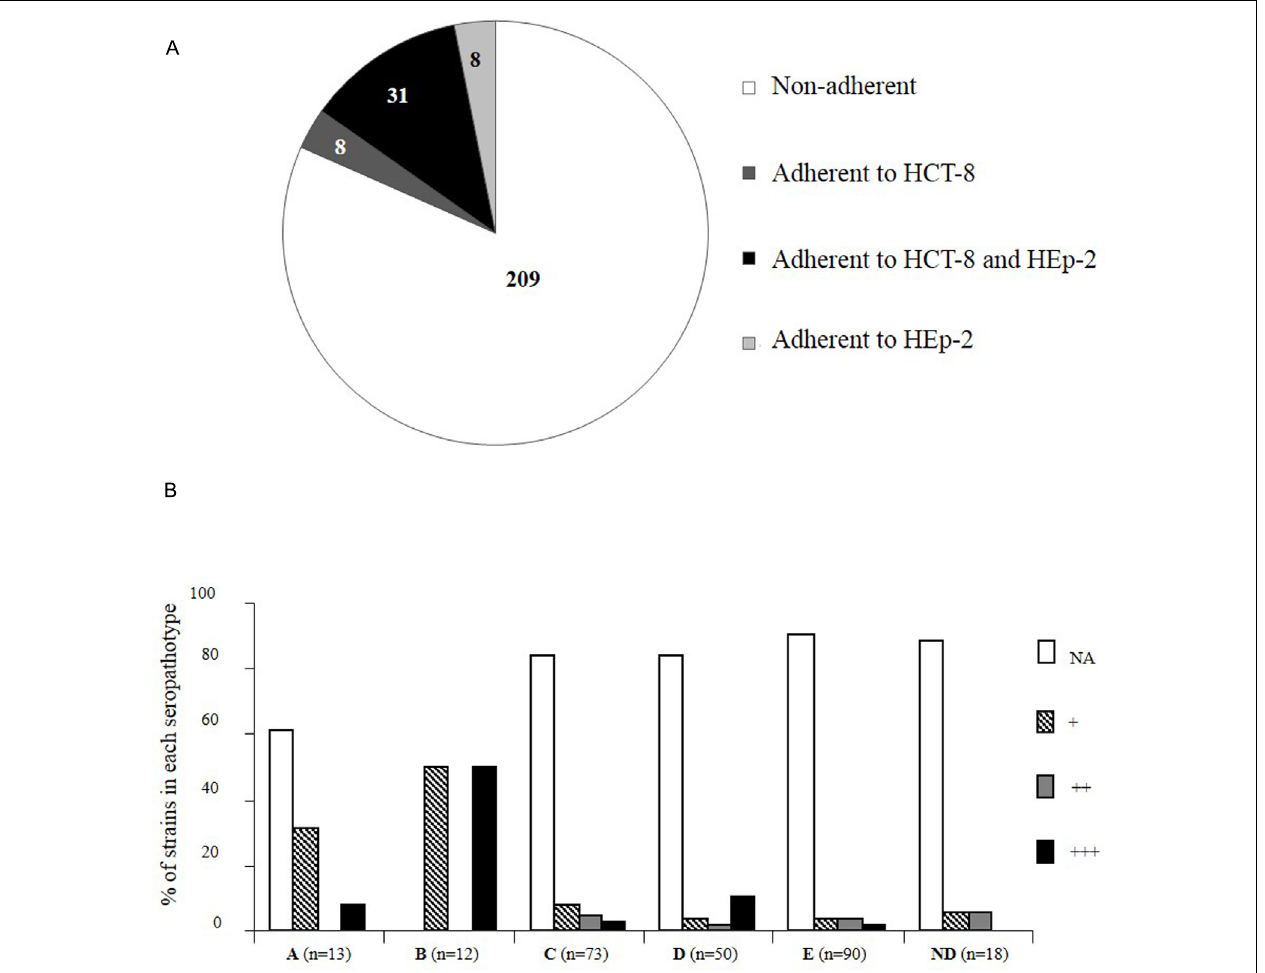
FIGURE 3 | Distribution of Shiga-toxin producing E. coli strains according to adhesion properties to HCT-8 and/or HEp-2 cell lines and seropathotype. (A) Number of STEC strains adherent to HCT-8 and/or HEp-2 cells or non-adherent (NA; less than 1 bacterium per cell). (B) Results are expressed as the percentage of strains that adhered or not, and the level of adhesion, in each seropathotype. + ,